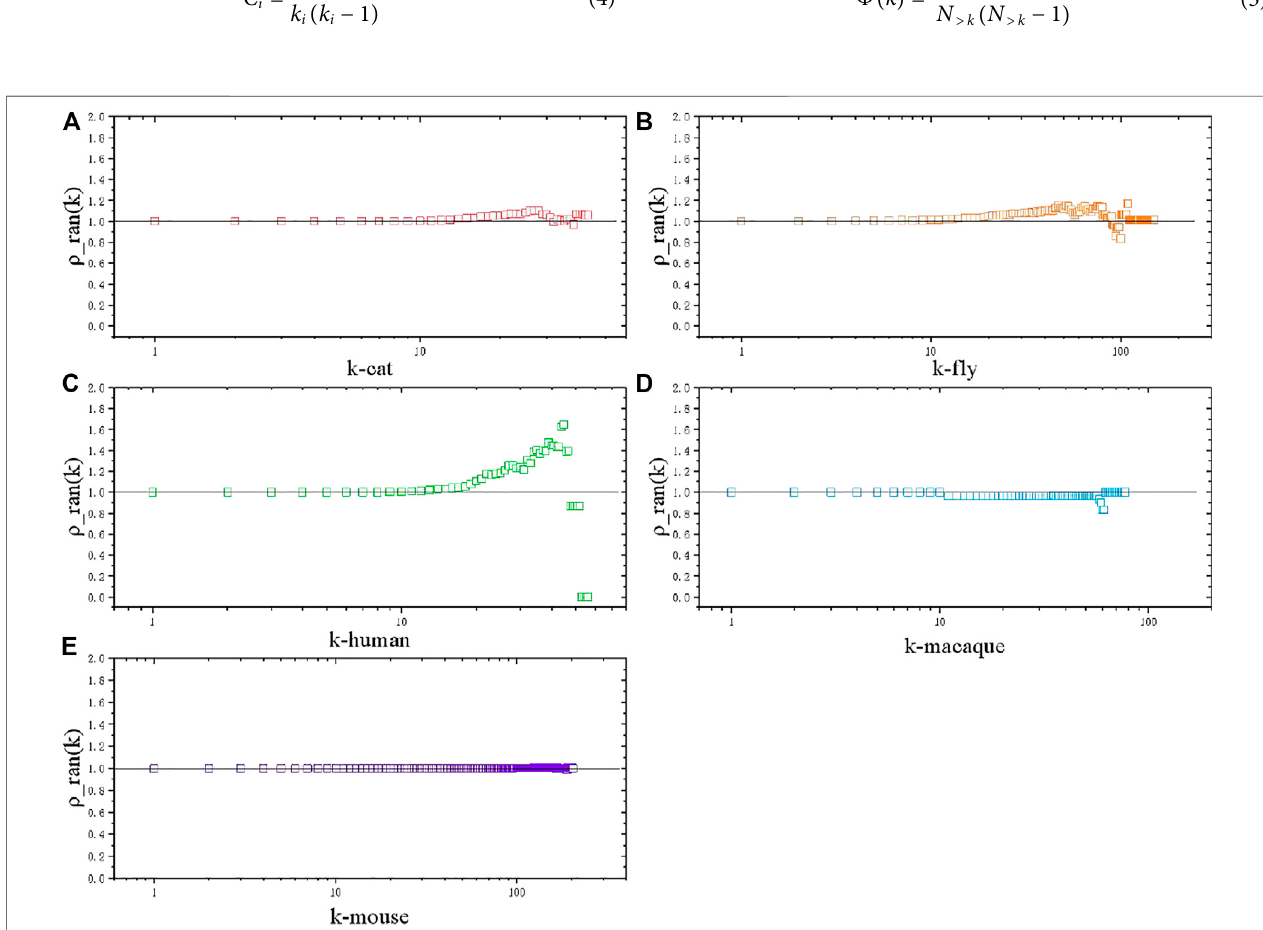
FIGURE3| Richclubcoef fi cient,normalizedbythenullmodel. (A) Catbrainnetwork. (B) Flybrainnetwork. (C) Humanbrainnetwork. (D) Macaquebrainnetwork. (E) Mouse brain network.